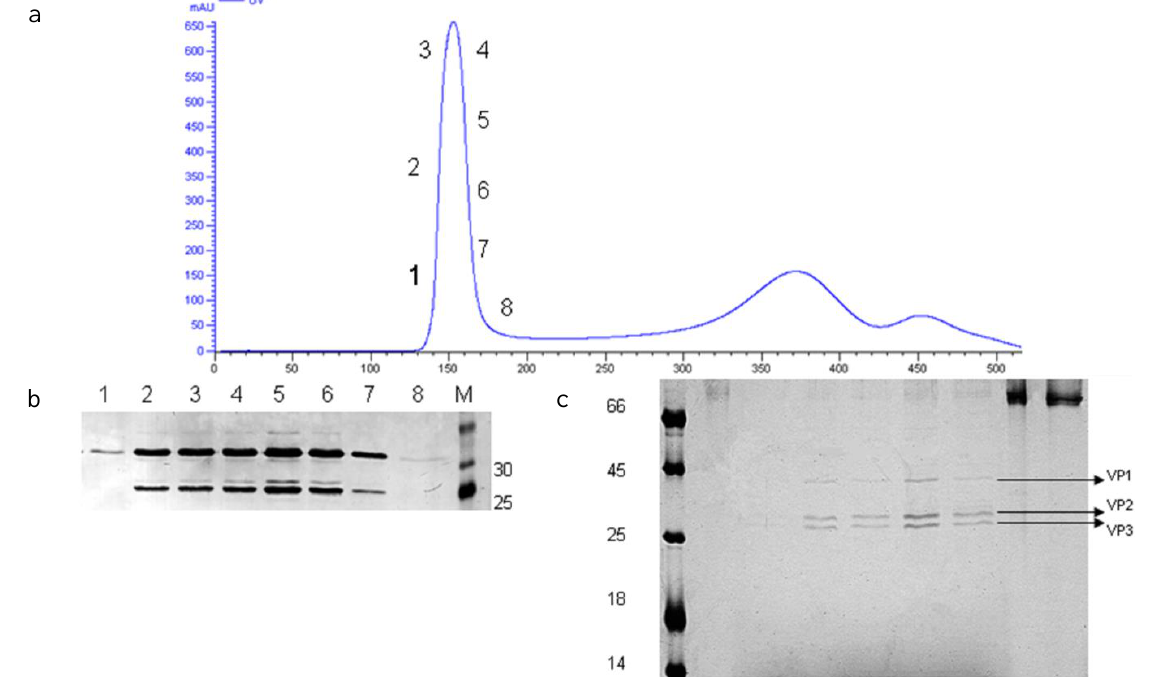
Figure 7. Gel filtration chromatography. ( a ) Elution profile of virus concentrate loaded and separated on the Sepharose Fast Flow 6 column using an AKTA system and